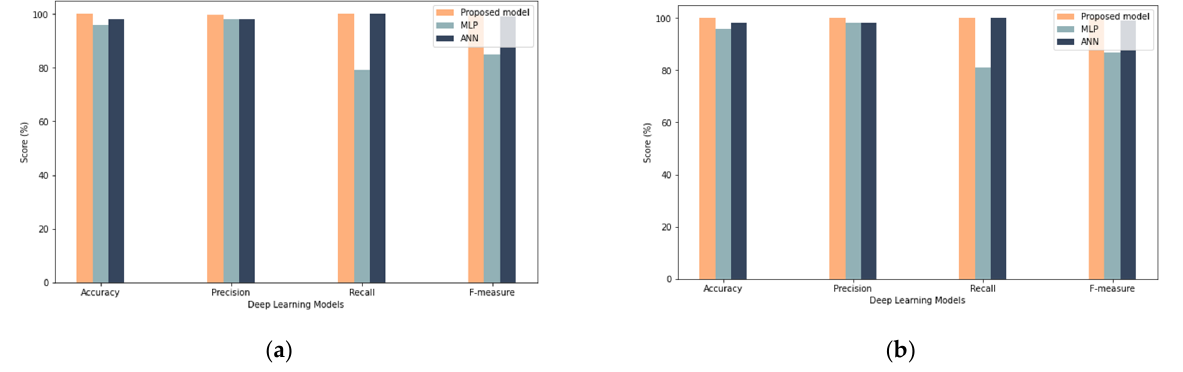
Figure 14. Comparison with deep learning results: ( a ) results for the 100% sample size with 50 iter- ations, ( b ) results for the 100% sample size with 100 iterations.